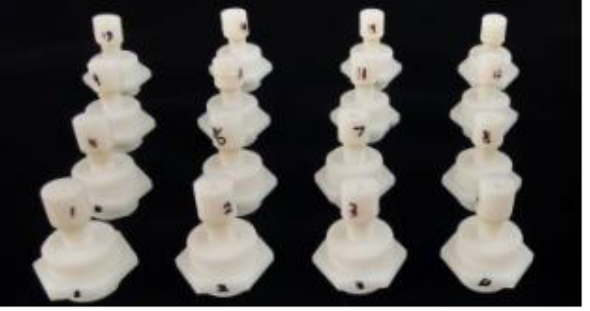
Figure 10. Sprinklers of the orthogonal experiment for the spraying pesticide.